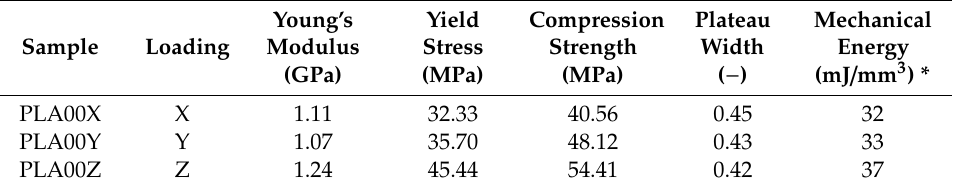
Table 1. Compression properties of fully dense 3D printed